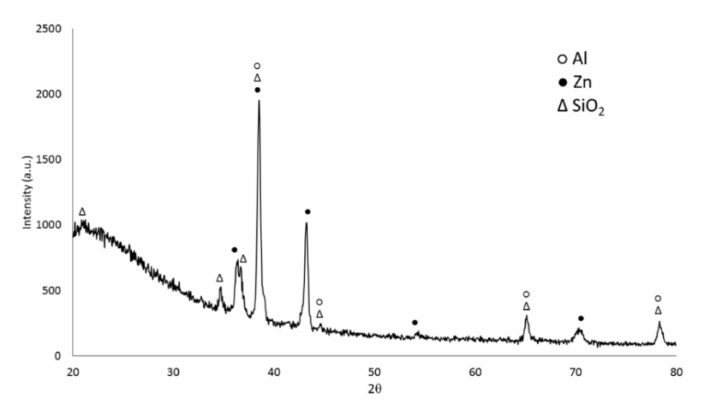
Figure 4. XRD analysis of the sample obtained at 2.3 A / cm 2 for 2